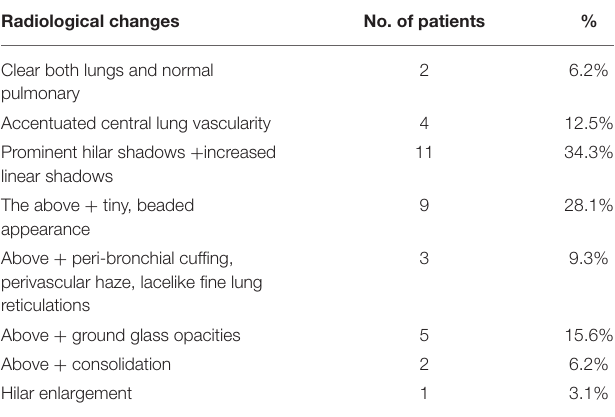
TABLE 4 | Chest radiographic findings in COVID-19 positive infants. Radiological changes